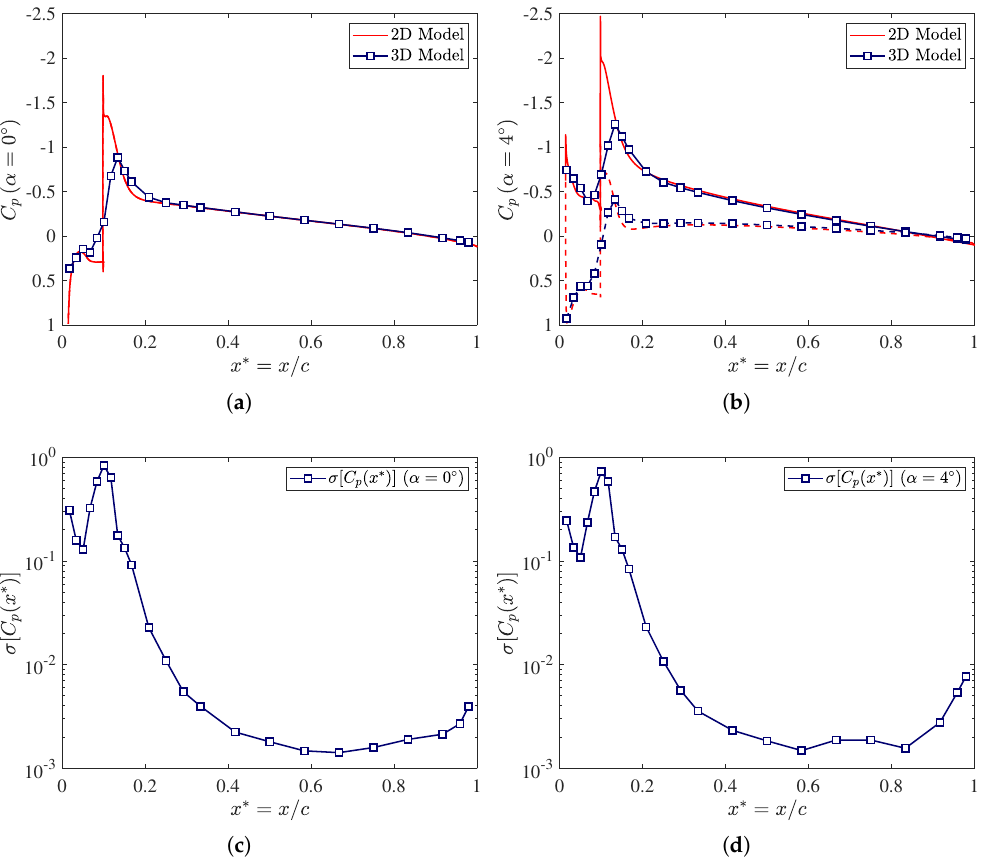
Figure 18. Pressure coefficients comparison between the 2D damaged airfoil and the 3D eroded blade. Distributions on the pressure side are denoted with the dashed line while solid lines are used for suction side trends. Dark blue squares denote the C p ( x ∗ ) value over the three-dimensional blade. ( a ) Pressure coefficients comparison at 0 ◦ incidence; ( b ) Pressure coefficients comparison at 4 ◦ incidence; ( c ) Pressure coefficient standard deviation on the blade at 0 ◦ incidence; ( d ) Pressure coefficient standard deviation on the blade at 4 ◦